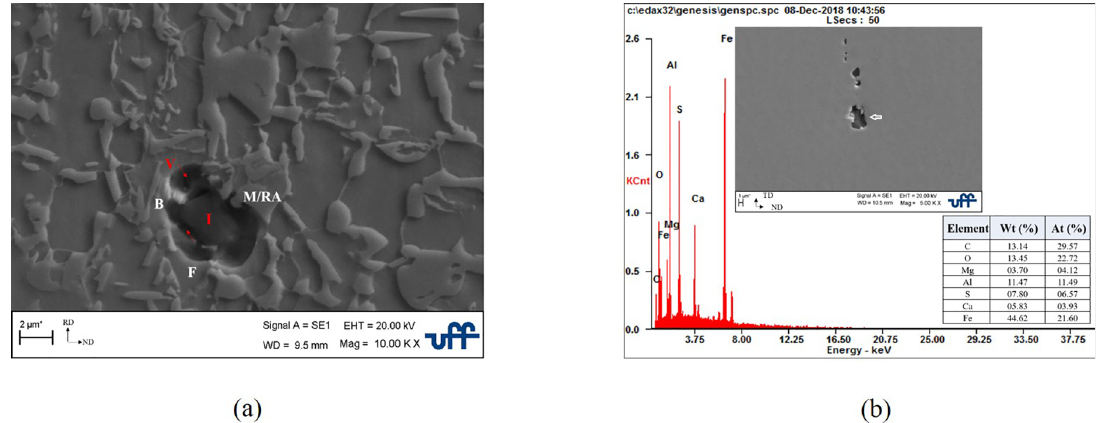
Figure 4. Inclusions aspects of the TRIP780 steel determined from the as-received condition: (a) scanning electron microscopy image (10000x) with an inclusion (I) at the ferrite (F) matrix surrounded by hard phases of bainite (B) and martensite/retained austenite (M/ RA) constituents and (b) energy-dispersive X-ray spectroscopy results of the inclusion indicated by an arrow (ND – Normal Direction, RD – Rolling Direction and TD – Transverse Direction).